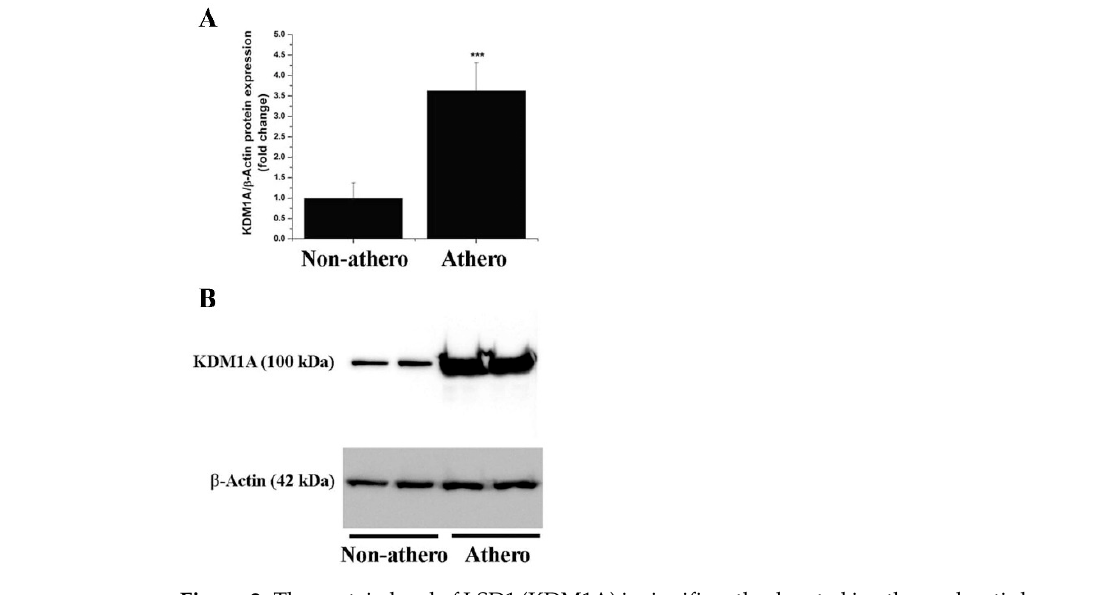
Figure 2. The protein level of LSD1 (KDM1A) is significantly elevated in atherosclerotic human carotid arteries. ( A ) Western blot assay-associated densitometric analysis depicting the LSD1 (KDM1A) relative protein expression level in human non-atherosclerotic STA and carotid artery-derived atherosclerotic tissue specimens. ( B ) Representative immunoblot showing the up-regulation of LSD1 (KDM1A) protein level in atherosclerotic tissue derived from human carotid arteries as compared to non-atherosclerotic arterial samples. n = 4–7, *** p < 0.001. p -value was taken in relation to non-atherosclerotic condition.